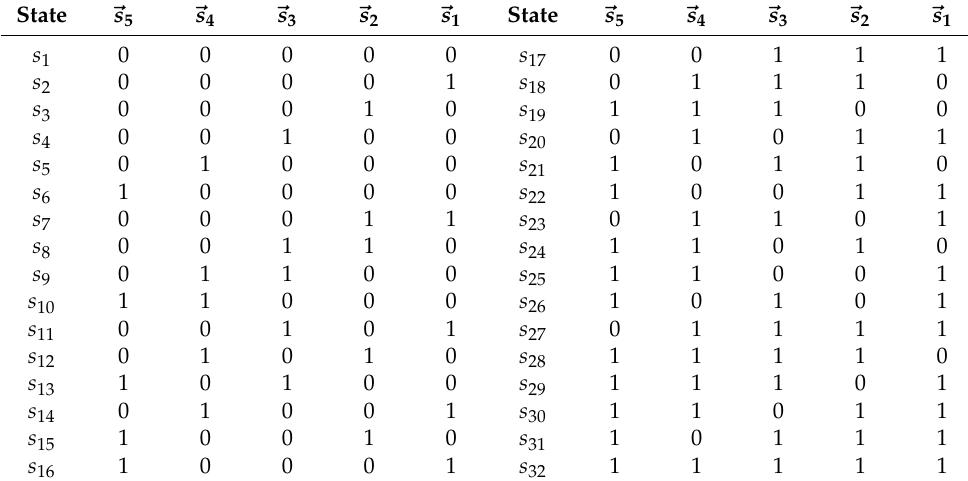
Table 1. State space of the top-coal